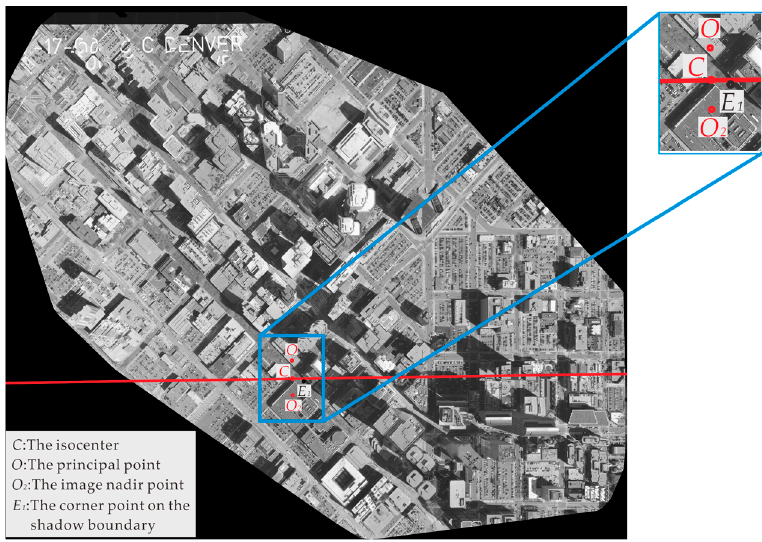
Figure 7. Selected shadow boundary point on the ghost image.